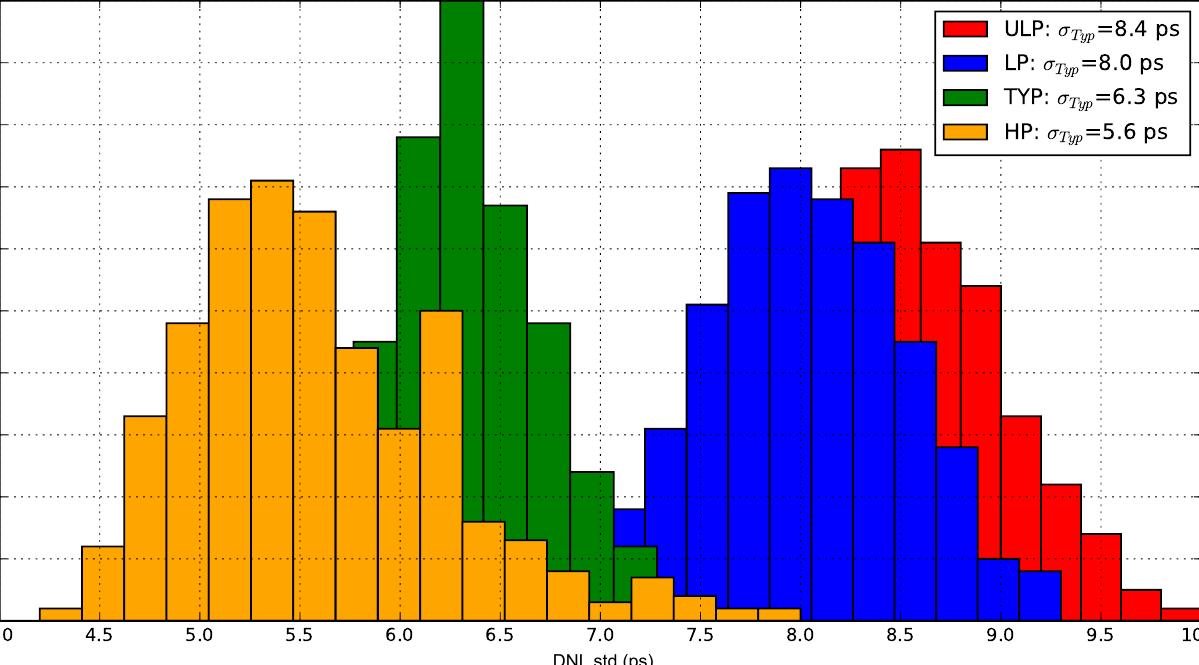
Figure 11. DNL standard deviation for each MATRIX16 channel sample (without